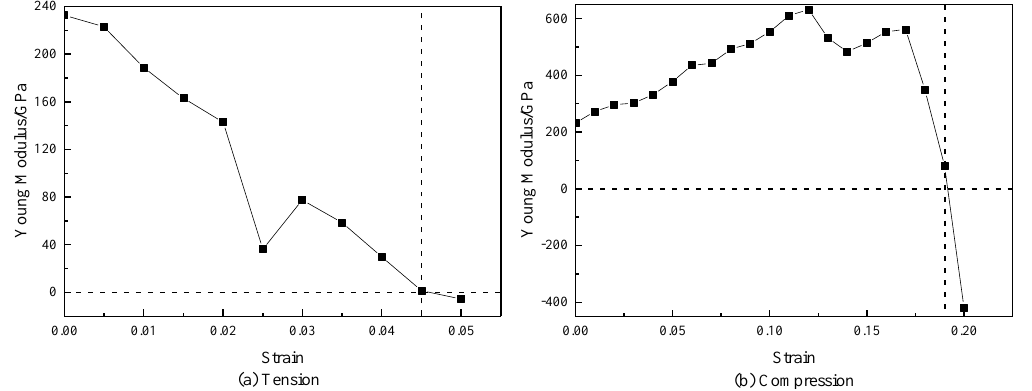
Figure 4. The change in Young's modulus in the process of tension and compression. ( a ) tension, and ( b ) compression.